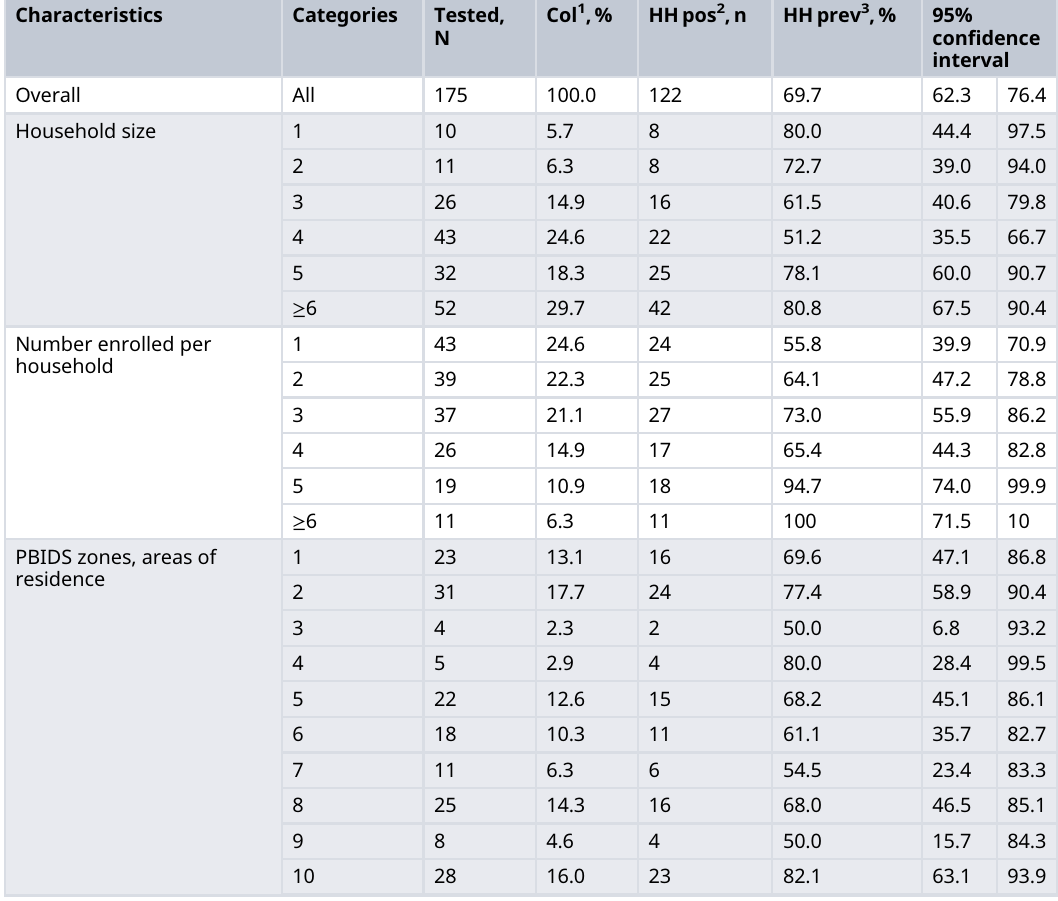
Table 2. Household characteristics and prevalence of households with seropositive individuals in Kibera urban informal settlement, Nairobi, Kenya.